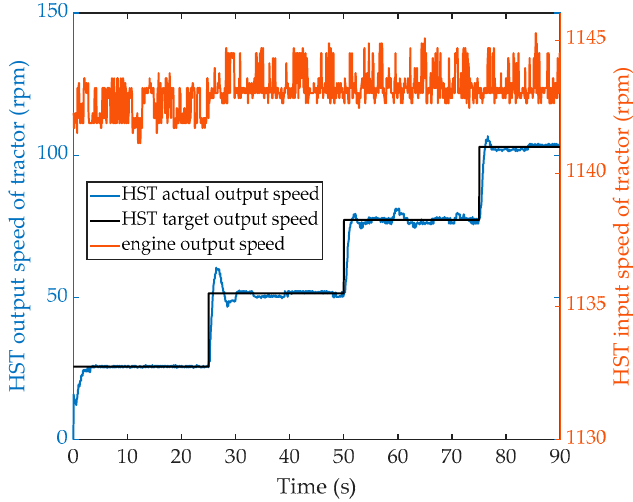
Figure 9. The PID-based constant speed step response curve.